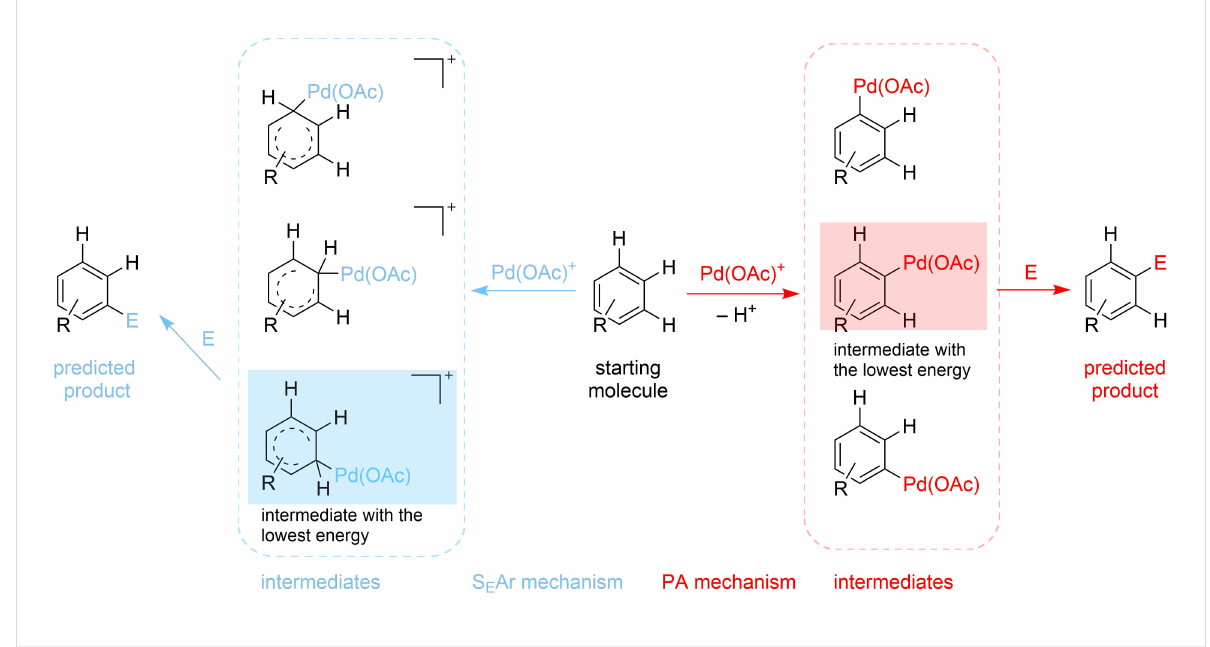
(i) erroneous optimisation to a saddle point where the